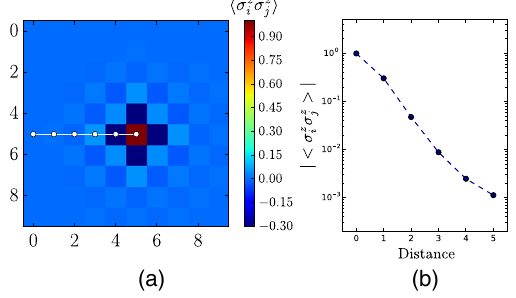
FIG. 6. Partition of the lattice used to compute the topological entanglement entropy.